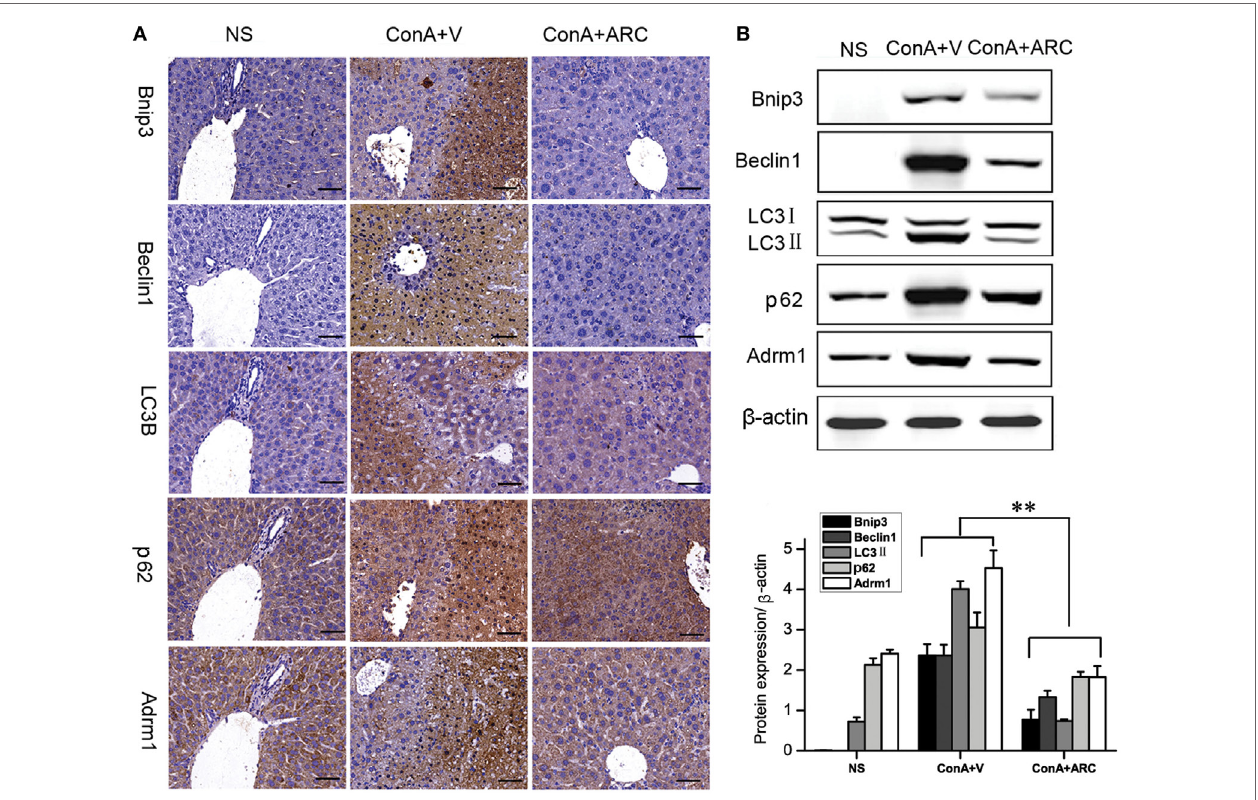
FigUre 8 | ARC downregulated apoptosis and autophagy in ConA-induced hepatitis. (a) The expressions of Bnip3, Beclin1, LC3B, p62, and Adrm1 were measured by IHC. (B) The protein levels of Bnip3, Beclin1, LC3B, p62, and Adrm1 were measured by Western blot. The values are represented as mean ± SD. ** p < 0.01 compared with model group ( n = 8). The mice pre-treated with vehicle were used as model